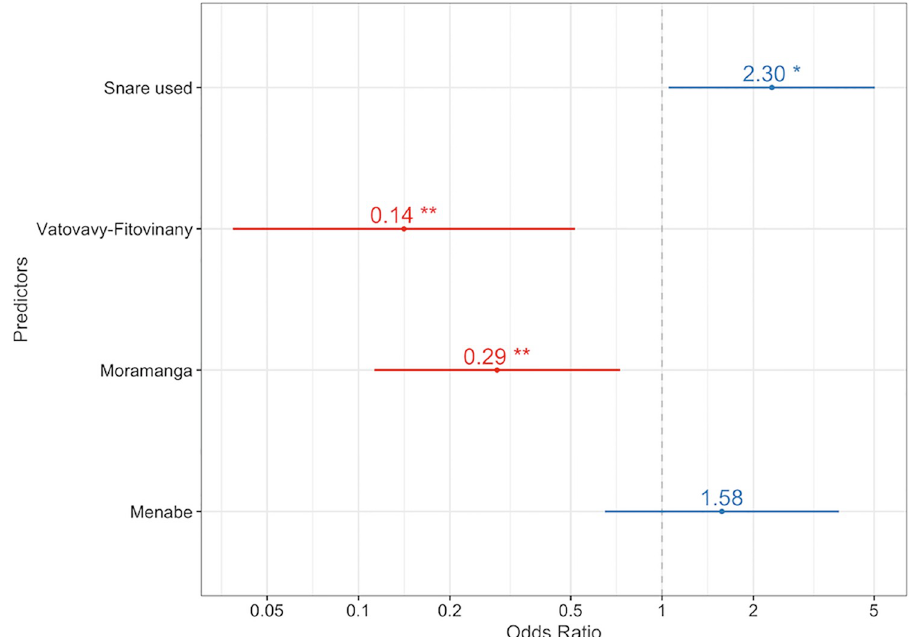
Fig 2. The significant predictors of fosas’ reported predation of poultry (with 95% confidence intervals). The x- axis displays the odds of households sustaining poultry predation that were located in a region or used a snare, against Boeny the reference region. The level of significance is denominated by � p < 0.05, and �� 0 < 0.01.